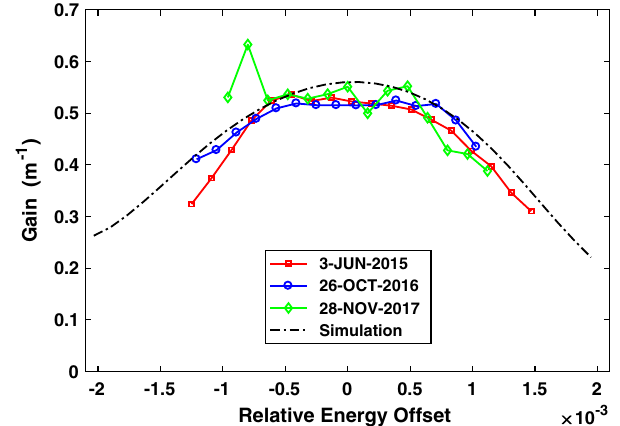
FIG. 4. Experimental and computed exponential gain coeffi- cient for the amplified seed energy versus relative e-beam energy. Statistical fit errors (RMS) are generally ≤ 0 . 02 m − 1 for the JUN2015 and OCT2016 data. The black line labeled “ Simu- lation ” refers to time-steady GINGER code